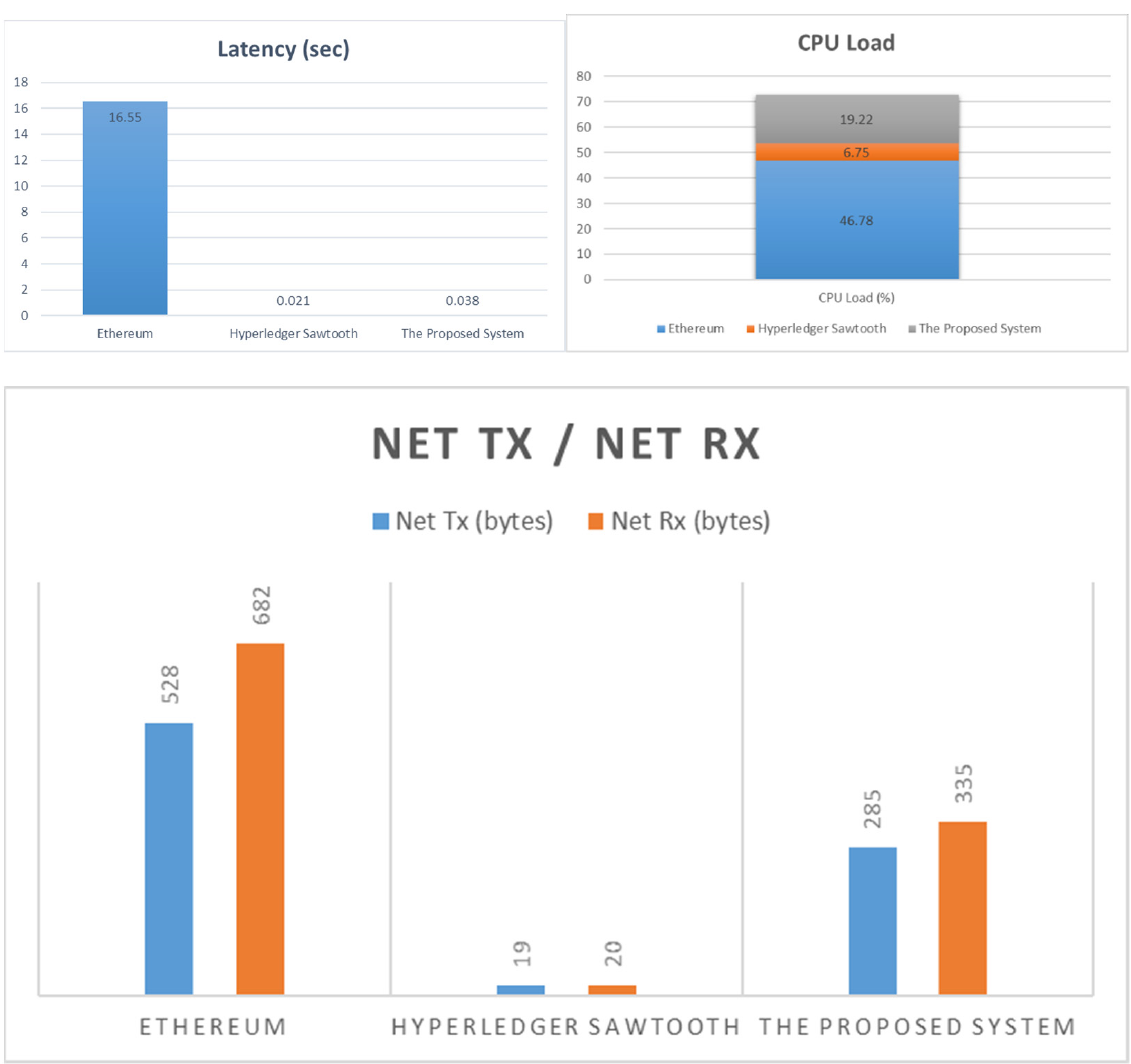
Figure 13. Benchmark of performance values